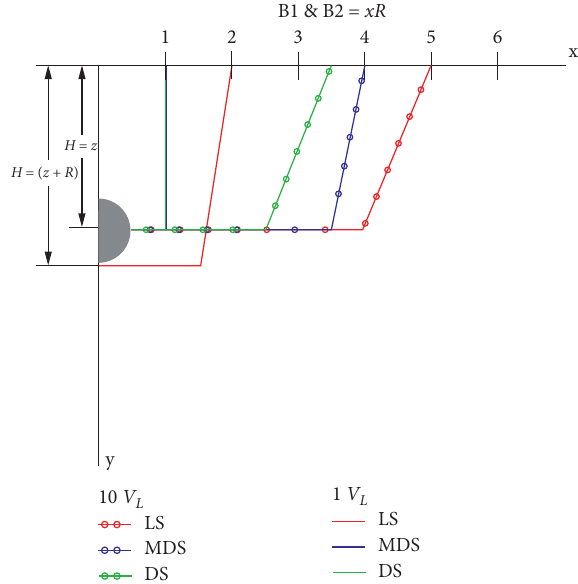
Figure 11: Influence zones for medium tunnel ( D � 6m). B1 and B2 are top and bottom width of influence zone measured in terms of tunnel radius “ R .” “ H ” is height of influence zones in terms of tunnel diameter “ D